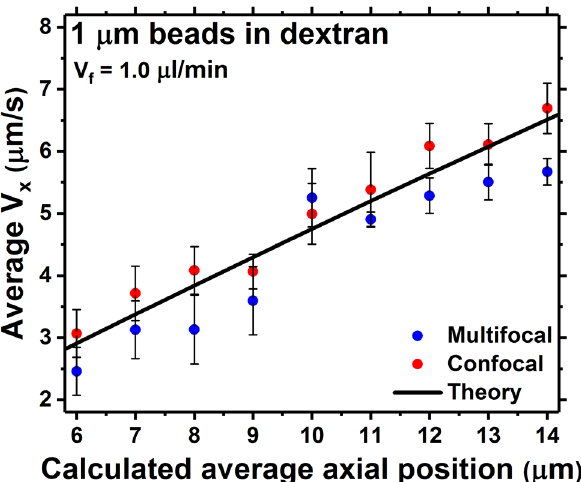
Figure 2. Theoretical V x against axial position curve (black curve), compared to the experimental curves calculated from the bead flows acquired by using the confocal (red curve) and the multifocal (blue curve) microscopes. Vf = 1.0